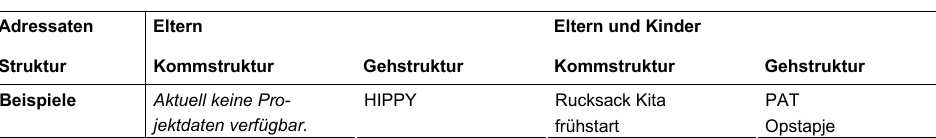
Tabelle 2 : Exemplarische multimodulare